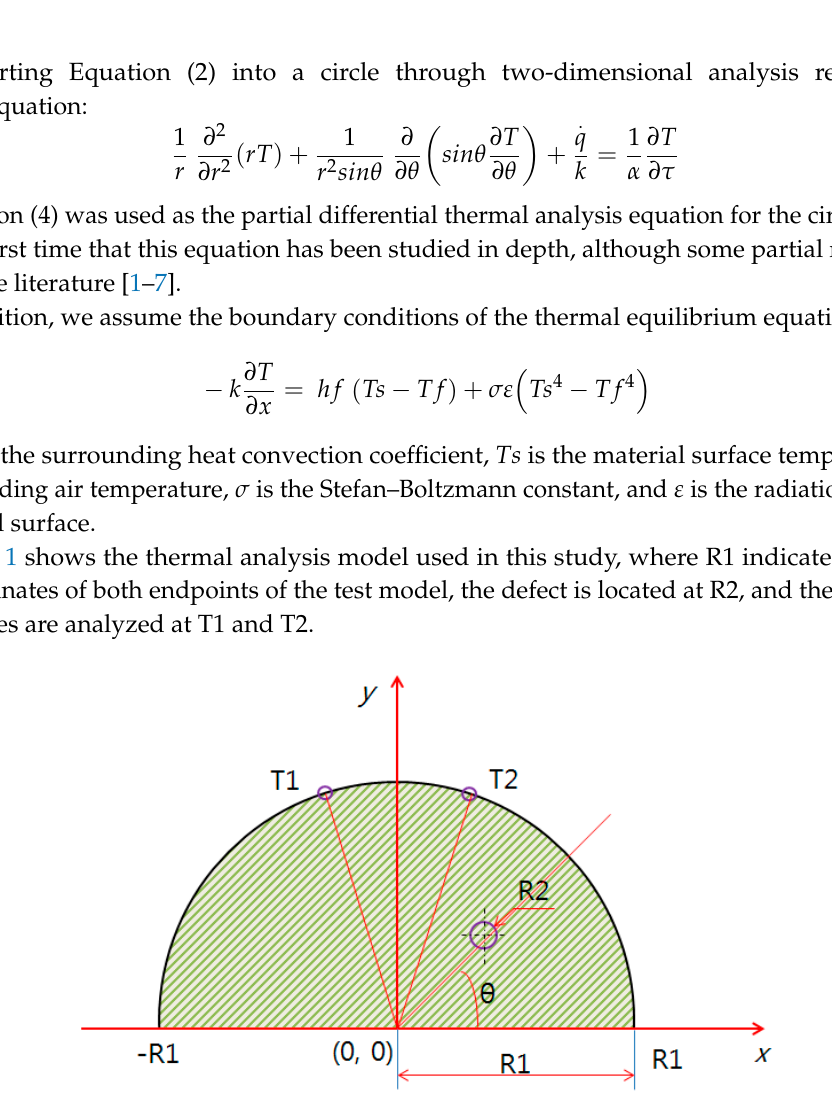
Figure 1. Modeling of the evaluation diagnosis.